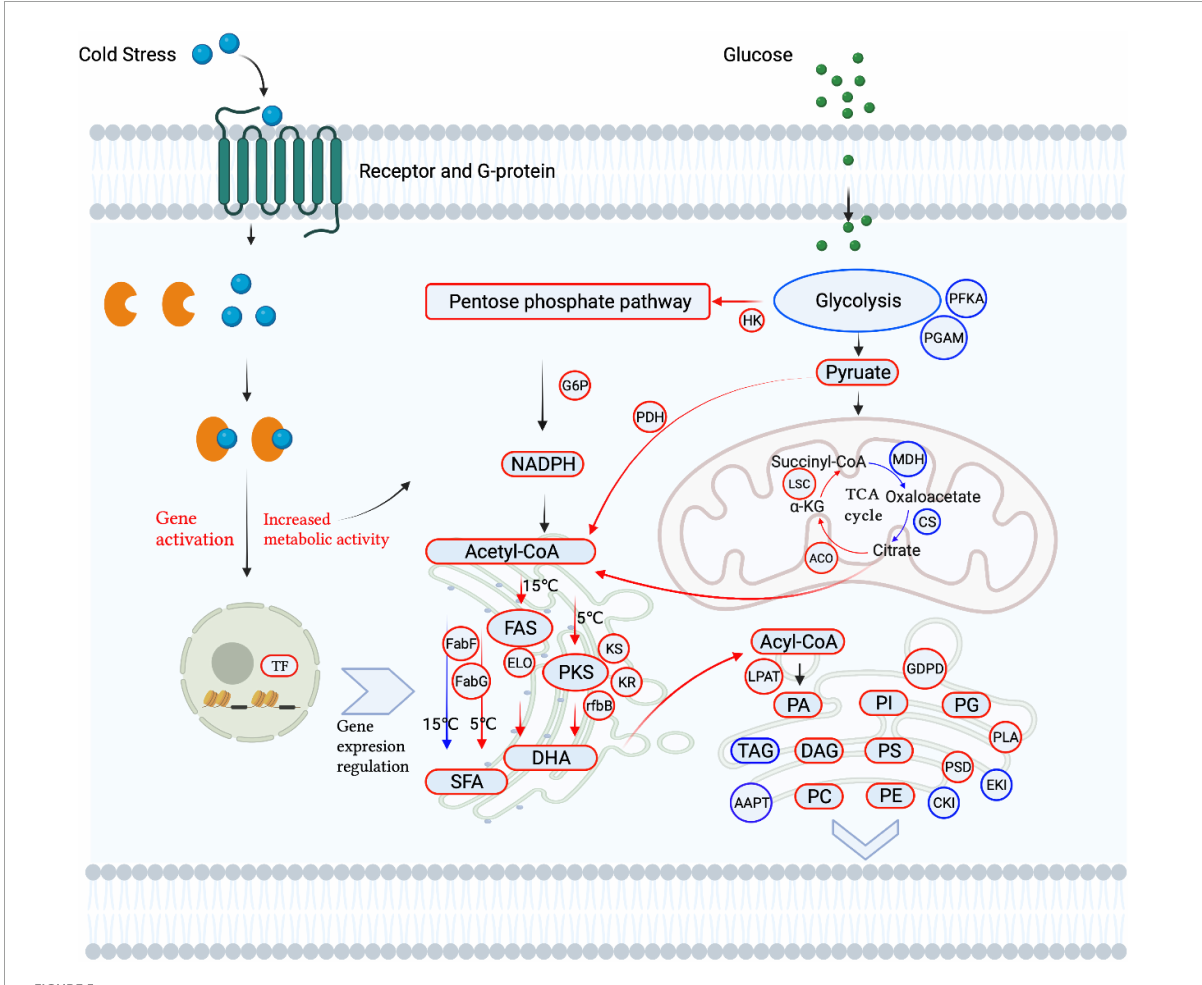
FIGURE5 Schematic diagram of lipid metabolism affected by cold stress in Aurantiochytrium sp.